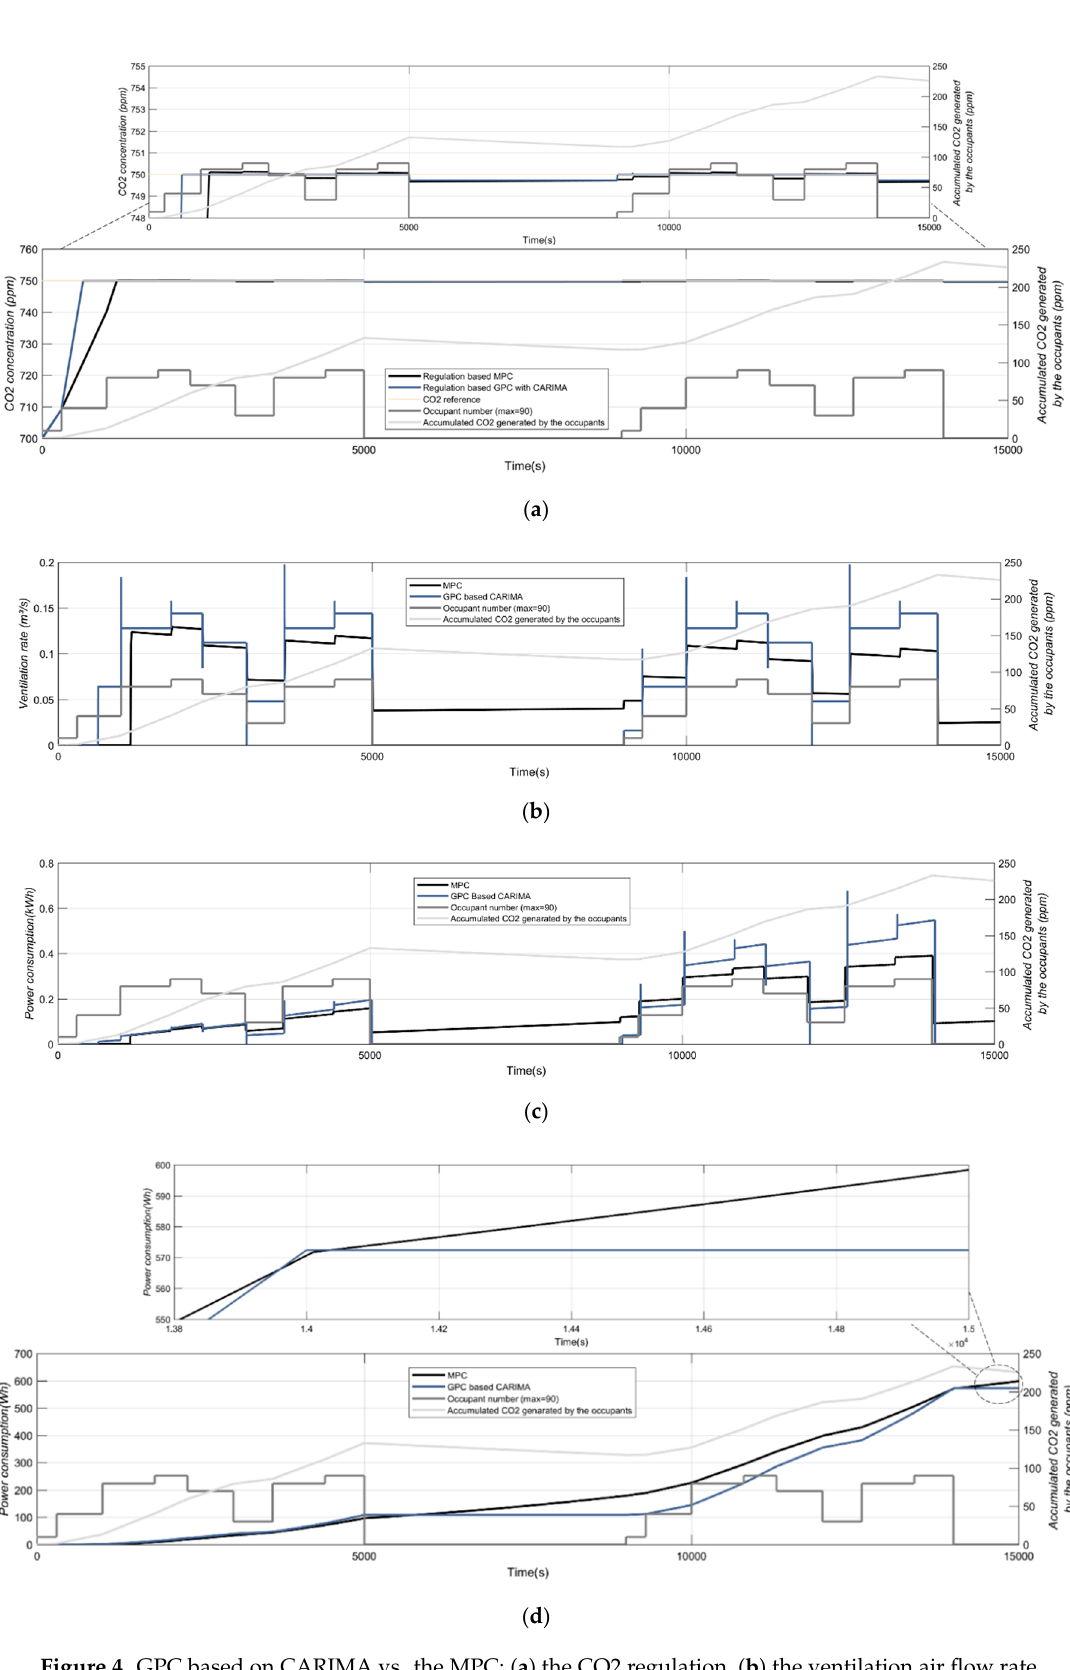
Table 4. Total energy consumption based on the predictive controllers.